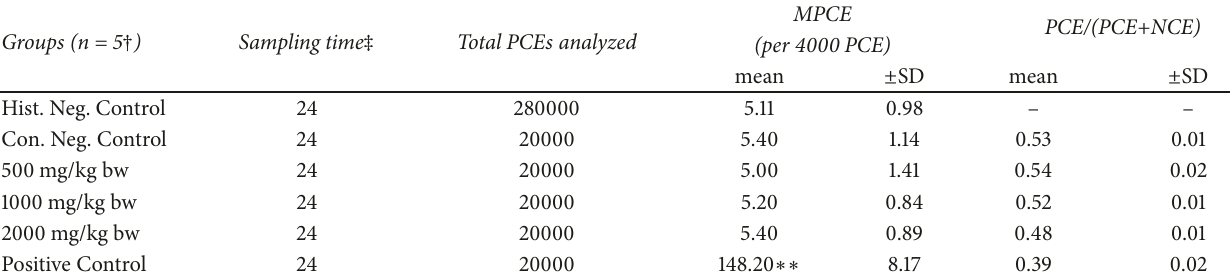
Table 3: Summary results of the in vivo mammalian micronucleus